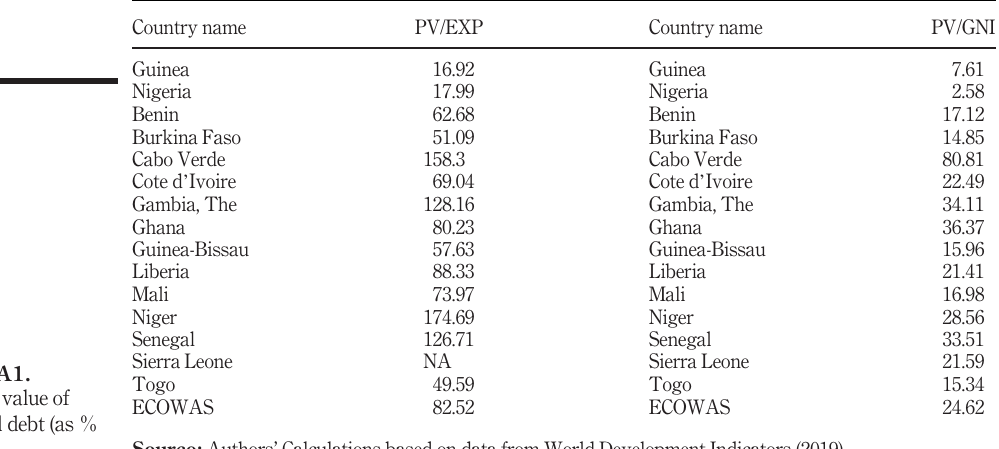
Table A1. Present value of external debt (as % of